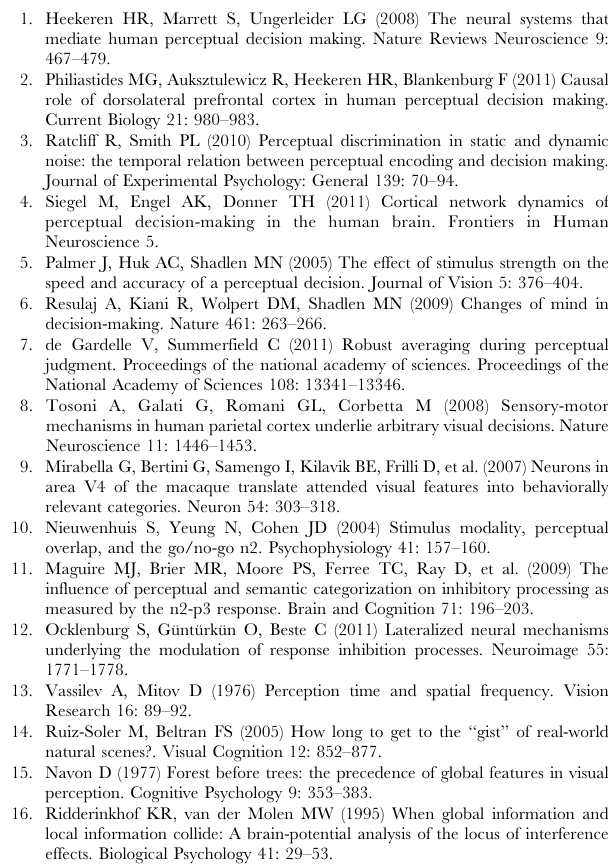
Figure S1 Examples of posterior predictives (grey lines) from the winning HDDM, on top of the observed normalized reaction time distributions (black) for a representative participant. Errors have been mirrored along the x-axis to display correct and incorrect RT distributions in one plot. A) visual stop task experiment 1, B) visual stop task experiment 2, C) visual cue stop task experiment 2. Figure S2 Posterior predictives (grey lines) and observed reaction times (black lines) in the visual speed-accuracy task (experiment 2) for a representative participant. A) Accurate instruction trials, B) speeded instruction trials. Table S1 Model selection with HDDM for the visual stop tasks. Table S2 Model selection with HDDM during